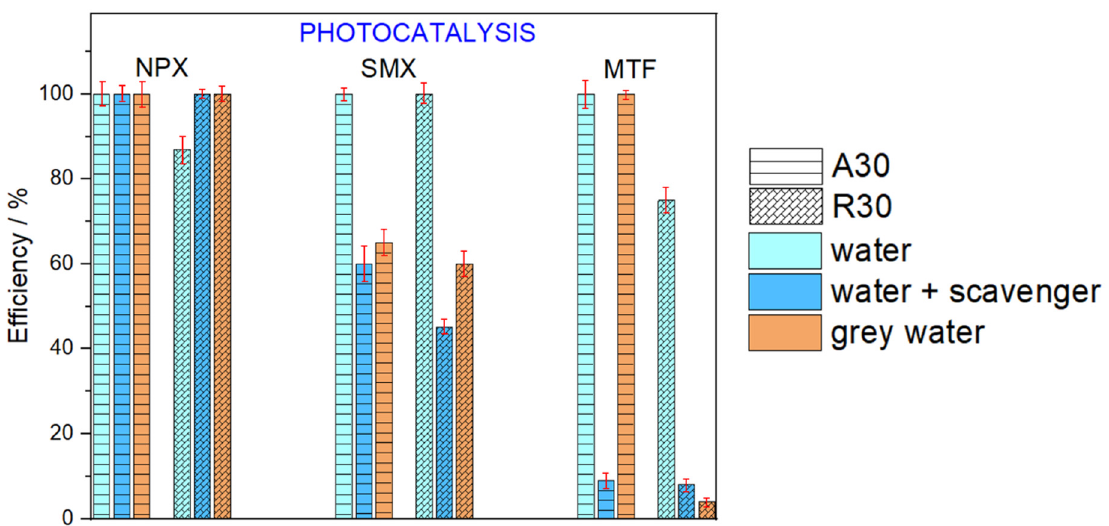
Figure 3. The comparison of the removal efficiencies of photocatalysis for naproxen (NPX), sulfamethoxazole (SMX) and metformin (MET) dissolved in ultrapure water, in ultrapure water with added scavenger and in grey water. The irradiation time equalled 5 h.